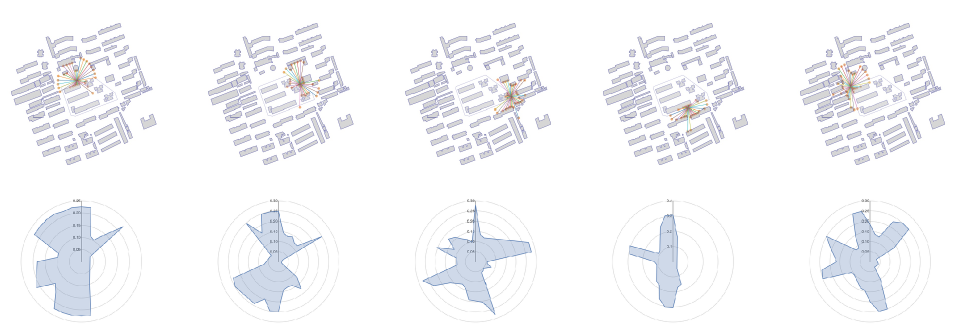
Figure 4. Allocation of the observers and the corresponding rays on a